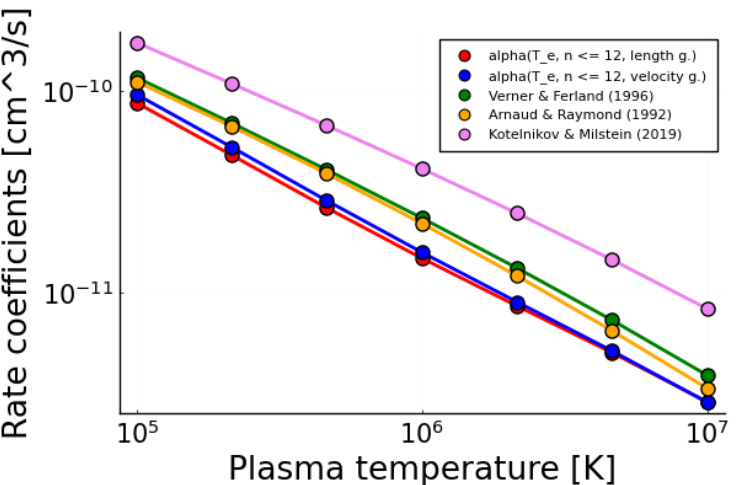
Figure 4. Total RR plasma rate coefficients as function of the (plasma) temperature T e for ini- tially helium-like Fe 24 + ions. Results from this work with electron capture into the n (cid:96) shells with n = 2 . . . 12 and (cid:96) ≤ f in length (red line) and velocity gauge (blue line) are compared with previous computations by Verner and Ferland ([13]; green line), the parametrization by Arnaud and Ray- mond ([10]; orange line) and the scaled analytical rates by Kotelnikov and Milstein ([42]; violet